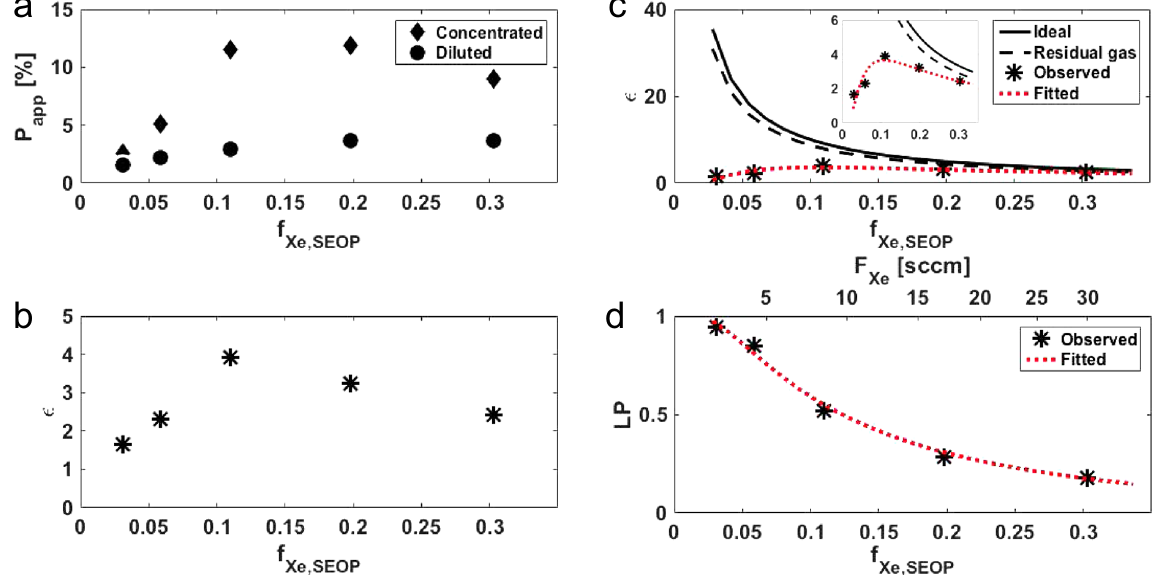
Figure 3. Dependence of 129 Xe signal enhancement on the Xe fraction in a dilute gas mixture. ( a ) Plot of P app as a function of f Xe,SEOP for a Xe/isobutene mixture. Data were obtained for a dilute Xe mixture without the separation (circles, the same data as shown in Fig. 2b) and for concentrated Xe after separation from isobutene at 196 K (diamonds). ( b ) Plot of enhancement factor ε as a function of f Xe,SEOP . Gas flow conditions used in these experiments were listed in Table 1. ( c ) Comparison of 129 Xe signal enhancement between experimental results and ideal conditions. Asterisks: observed enhancement factor, which are the same data as shown in ( b ) solid line: ideal enhancement factor; dashed line: ideal enhancement factor including residual isobutene at 196 K; dotted line: fitted curve using Eq. 11 with f ib,res = 0.13. Inset shows the expanded plot of the main figure for clarify. ( d ) Plot of 129 Xe polarization loss factor, LP , as a function of f Xe,SEOP . The flow rate of Xe is indicated above the plot. The plotted values were calculated using a relation of Eq. 10 with f ib,res = 0.13. The dotted line was drawn based on Eq. 13 using the values of α estimated from the fit as shown in c and f ib,res =